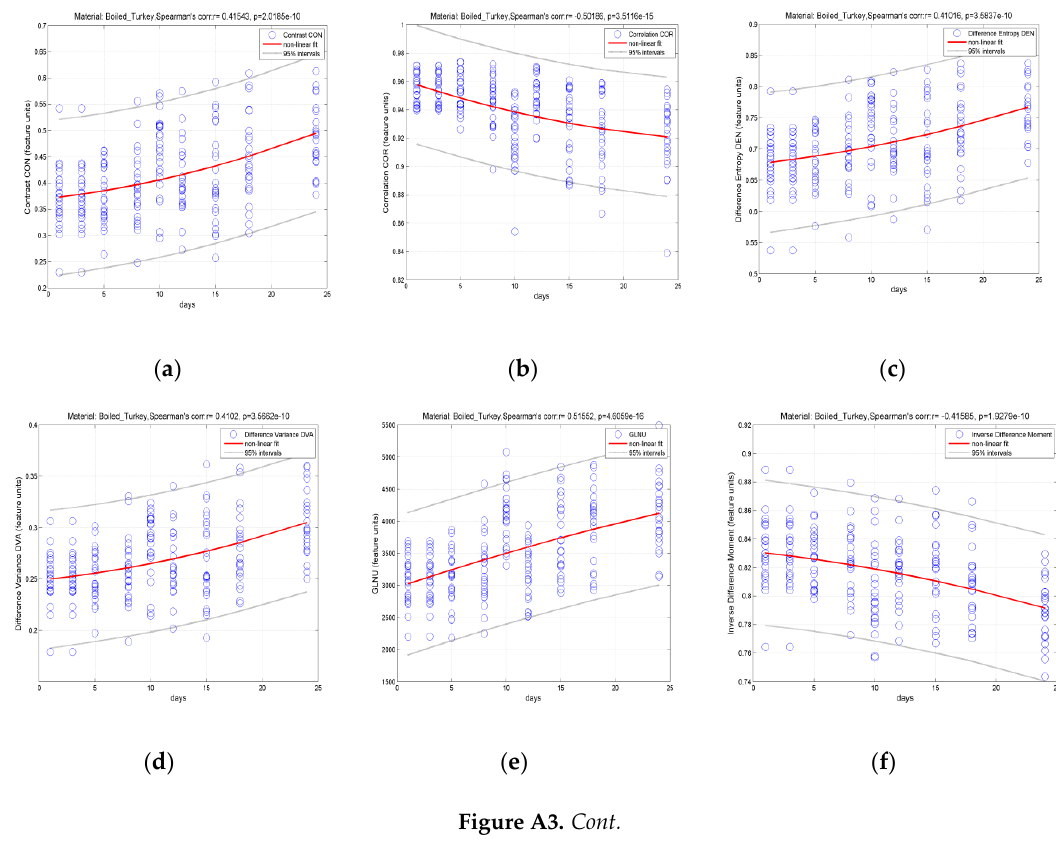
Figure A2. Variation of features ( a ) kurtosis and ( b ) mean intensity value of smoked pork hams during refrigerator storage.